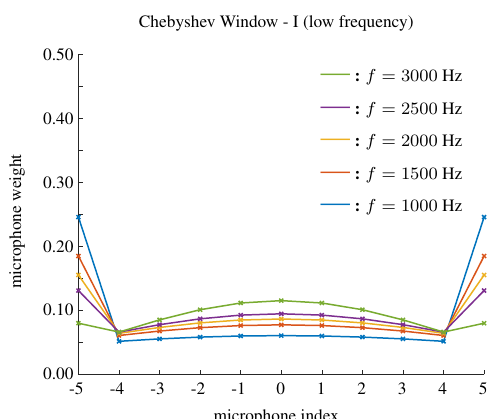
Figure 12. The weights of microphones for low frequency bins using the Chebyshev window-I, M = 11, δ = 3.5 cm.